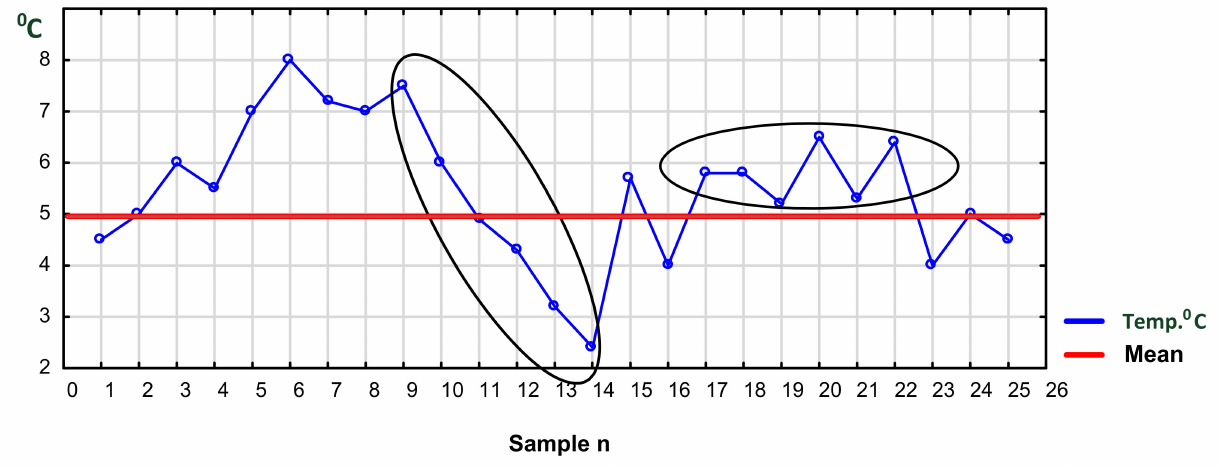
Figure 10. Some specific configurations of 5 or more samples (upward or downward) or five or more points above (or below) a mean line. Source: own